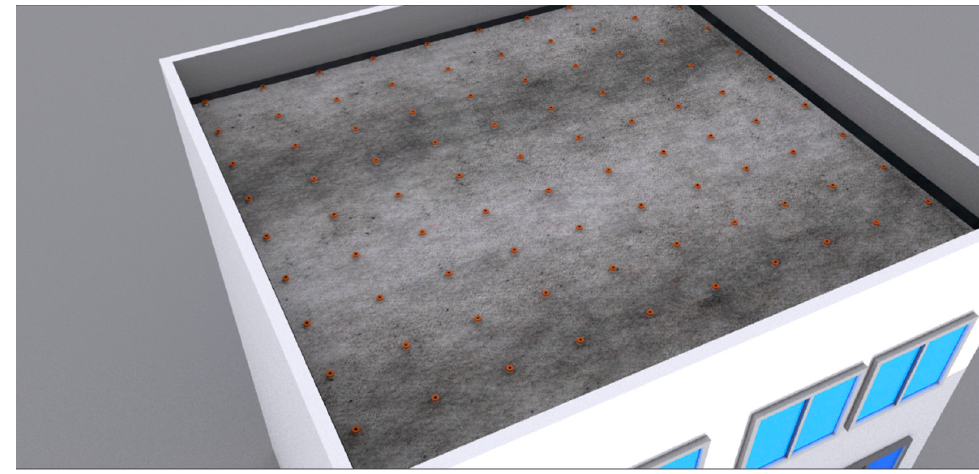
Figure 5. Waterproofing membrane layer.